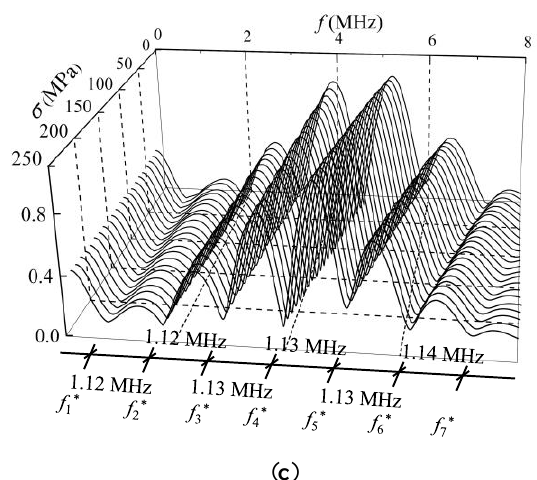
Figure 7. The normalized amplitude spectra under different compressive stress states in ( a ) sample C1; ( b ) sample C2; and ( c ) sample C3.